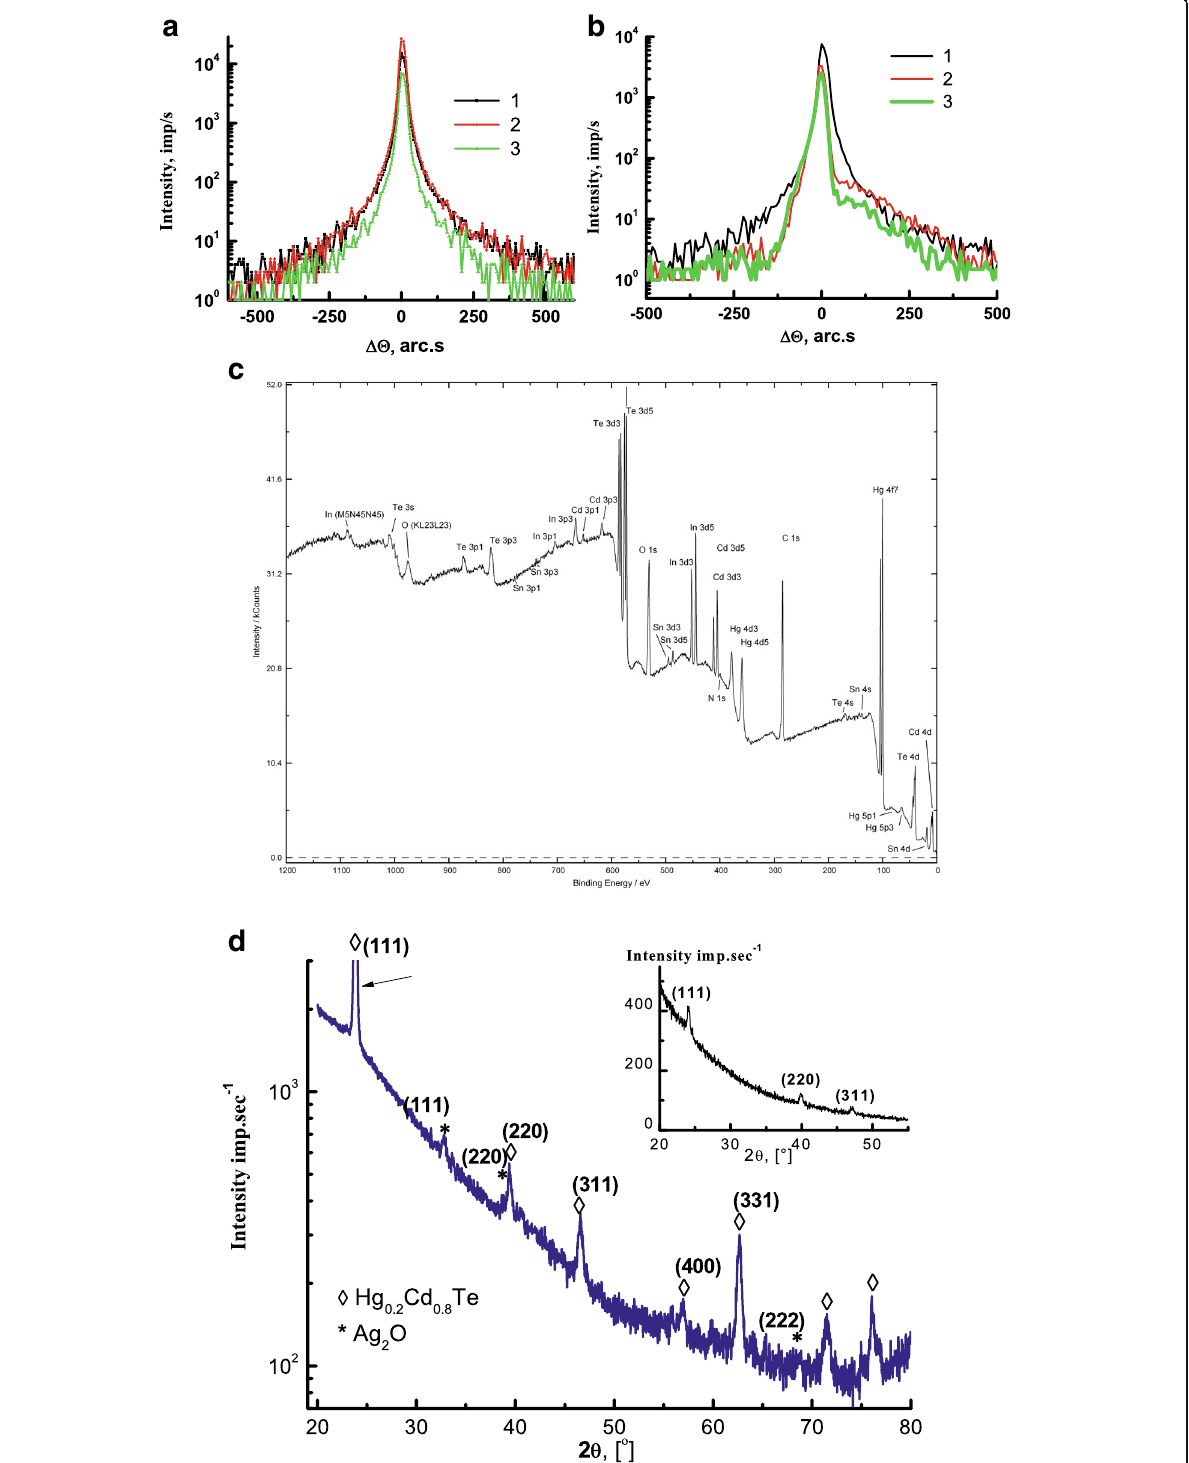
Fig. 2 XRD and XPS characterization of typical samples investigated. a X-ray rocking curves for MCT-based structure: 1 initial, 2 boron implanted, and 3 annealed. b X-ray rocking curves for MCT-based structure: 1 initial, 2 silver implanted, and 3 annealed. c XPS survey spectrum of MCT-based structure after silver ion bombardment and annealing. d GI XRD spectrum of MCT-based structure after silver ion bombardment and annealing. Inset shows the X-ray diffraction spectrum of the sample in the Bragg